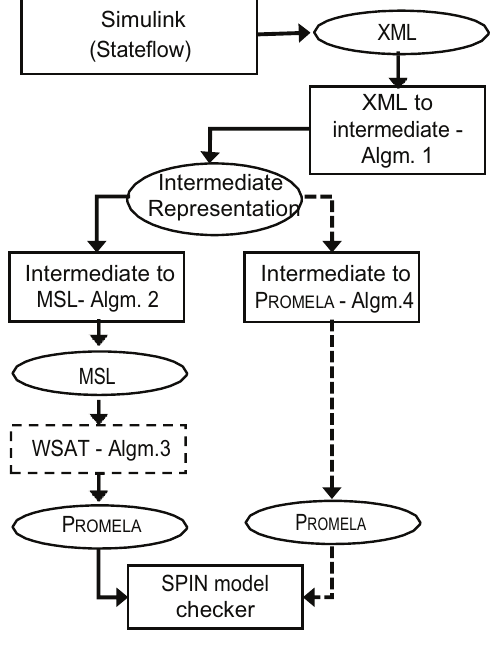
Fig. 1. Tool chains considered in this